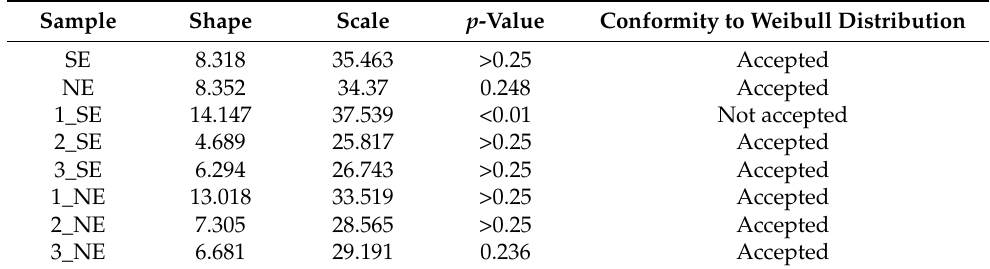
Table 4. Test of conformity to Weibull distribution of executed samples.